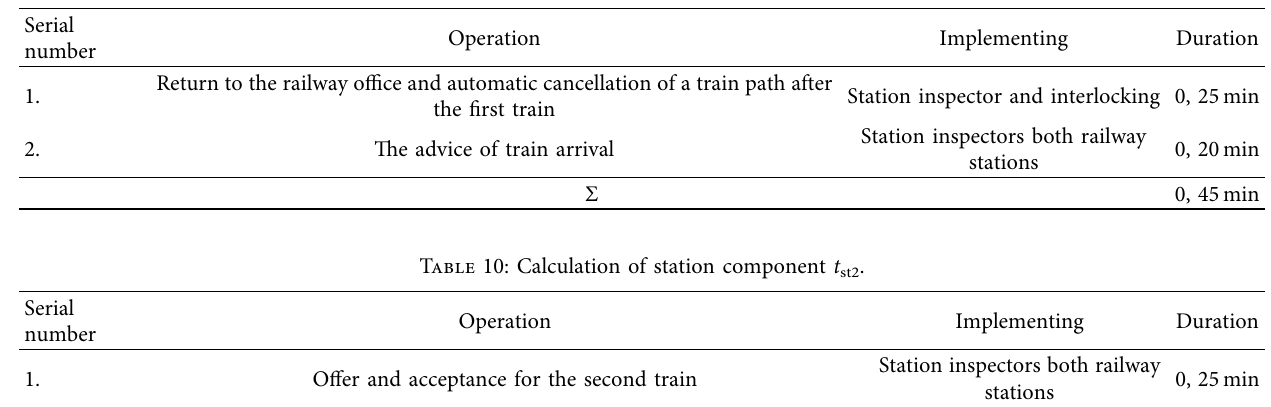
Table 9: Calculation of station component t